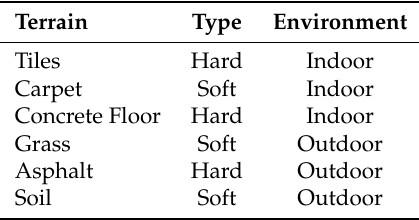
Figure 1. ( a ) Different types of terrains used for data collection; ( b ) strides of accelerometer gravitational axis ( y -axis); and ( c ) spectrogram of the signals. Table 2. Types of terrains used for collect data. The terrains were categorized into hard or soft surfaces and the data were collected in both indoor and outdoor environments.